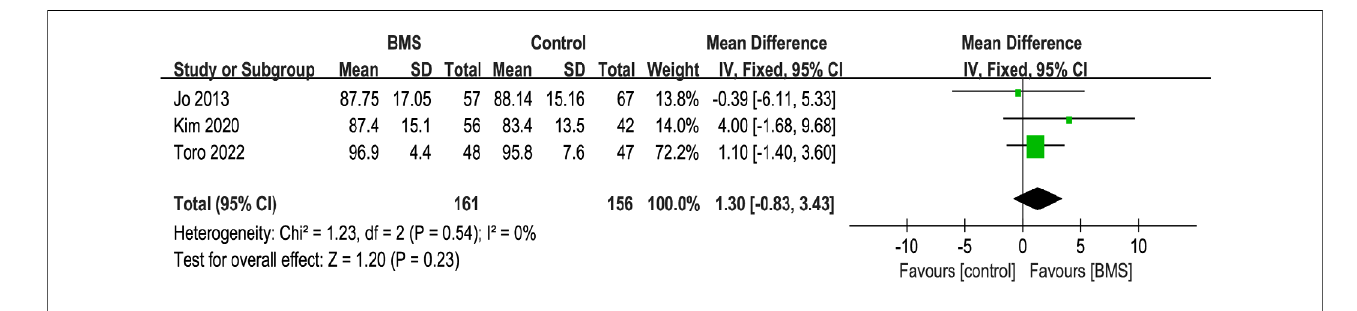
FIGURE 6 Forest plot comparing postoperative ASES scores between the BMS and control groups.